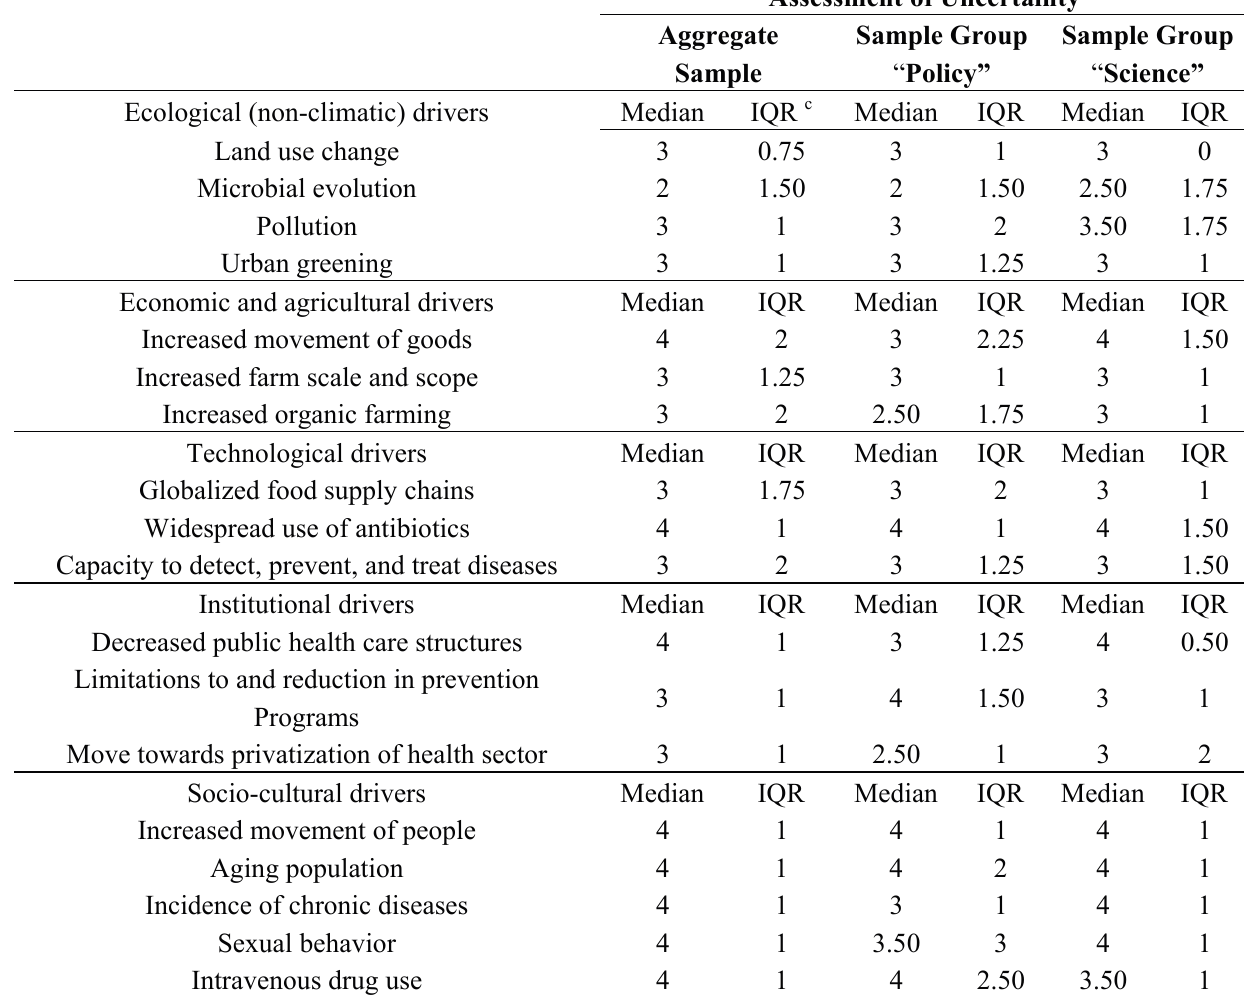
Table 3. Assessment results of the degree of uncertainty in the future development of each non-climatic driver, for the aggregate expert sample and for the two sample groups “Policy” and